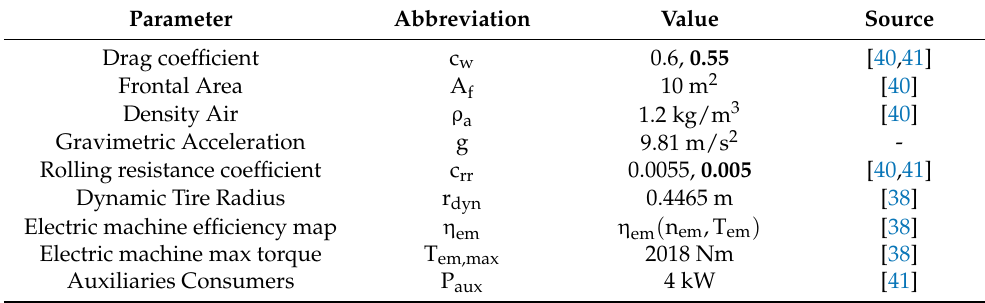
Table A1. Vehicle dynamics and powertrain parameters. The bold parameters are used in final